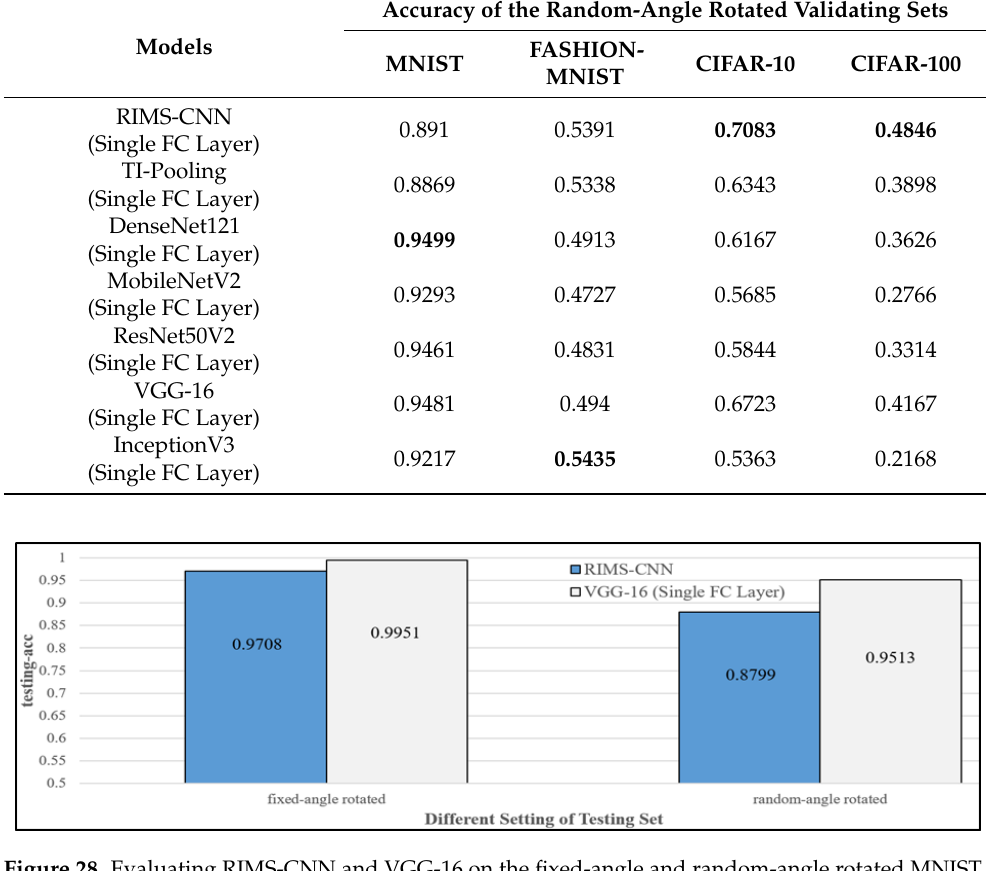
Table 6. Evaluating models on the random-angle rotated validating sets.